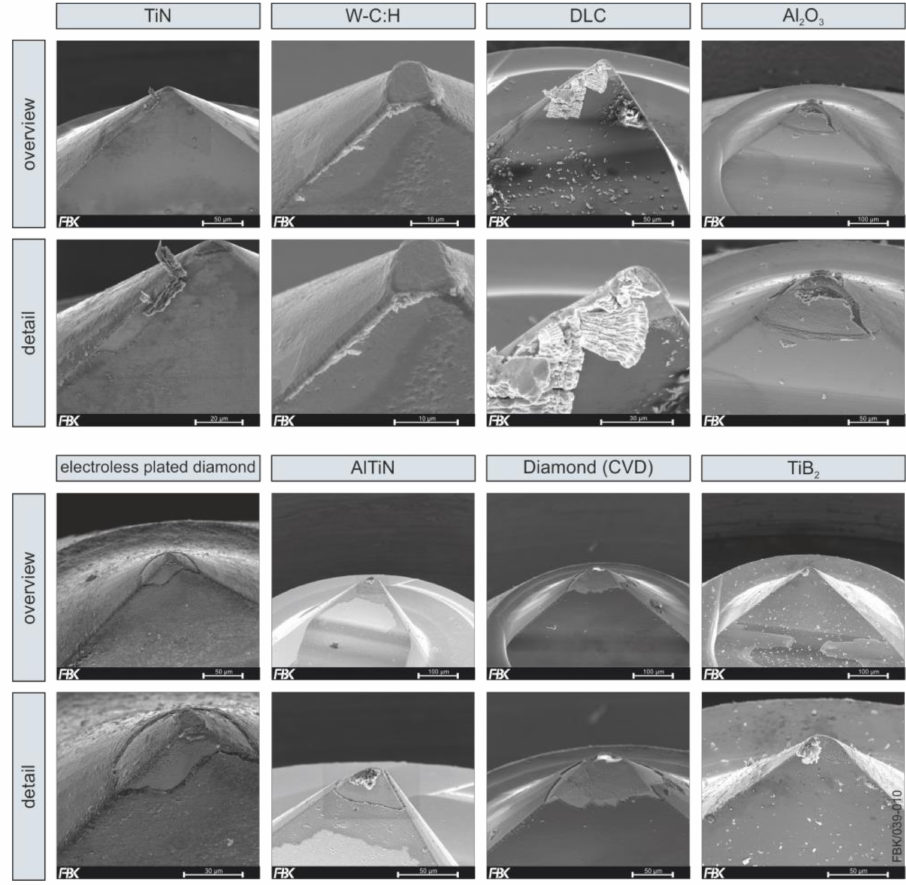
Figure 5. Coated micro end